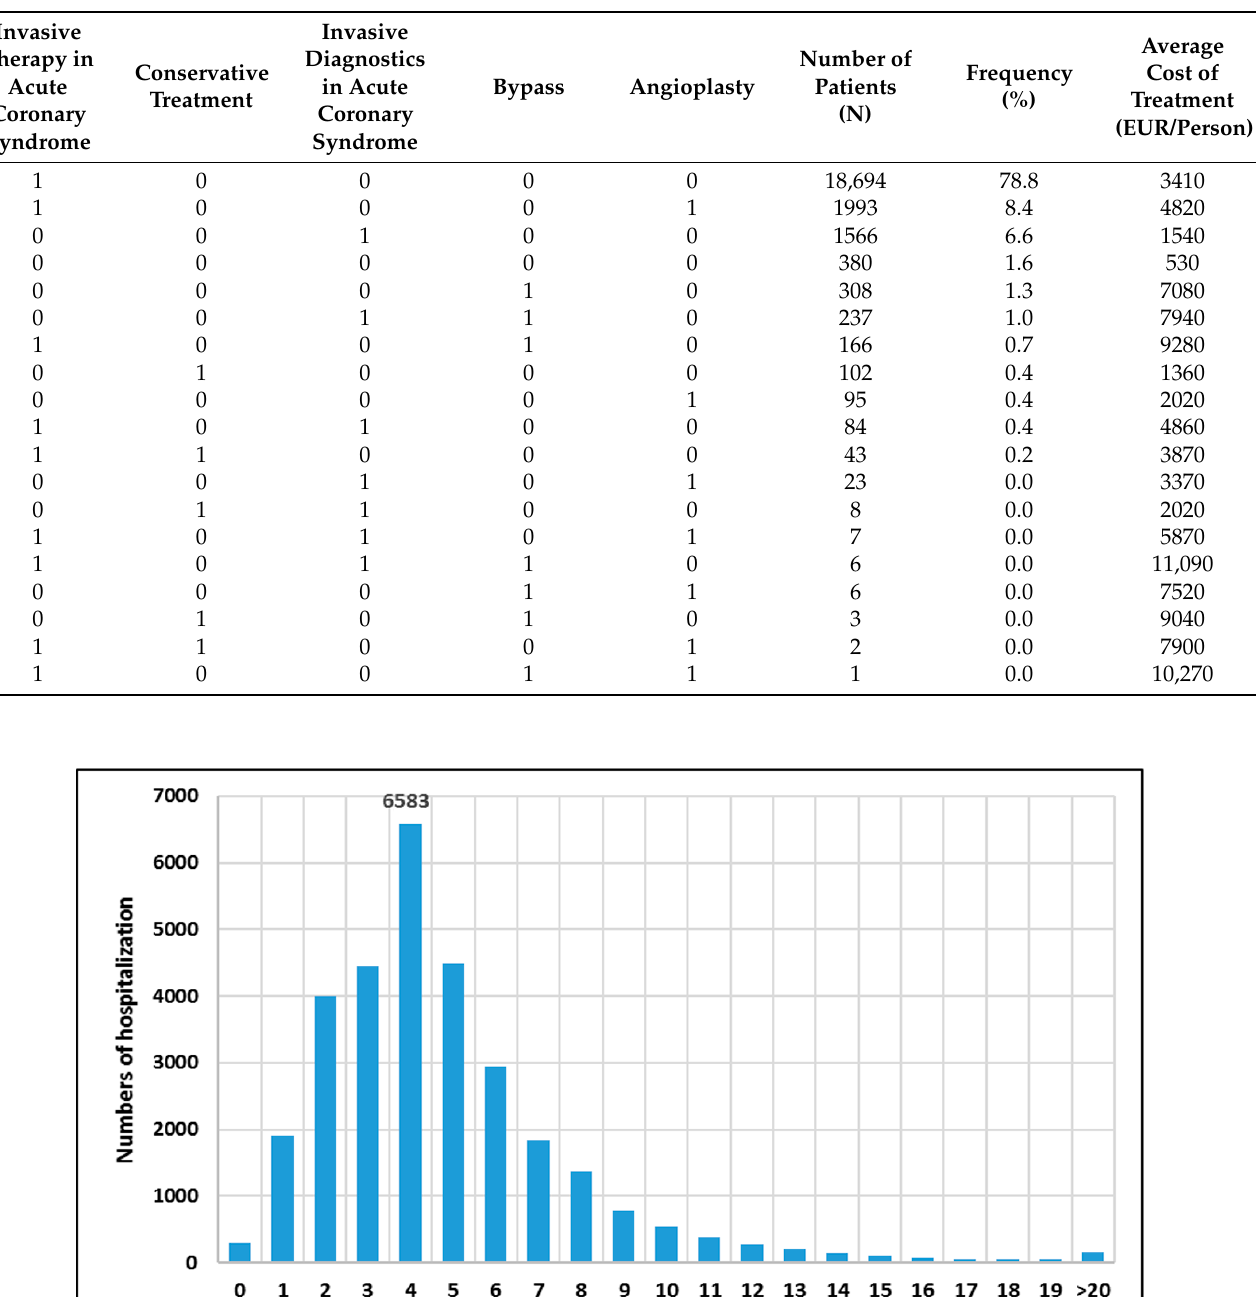
Table 2. Treatment combinations under Module I and the average cost associated with treating patients under CCMI as part of a given combination (n = 23,724). The number 0 means that the treatment procedure was not performed, while the number 1 means that the procedure was performed within the combination of treatment.